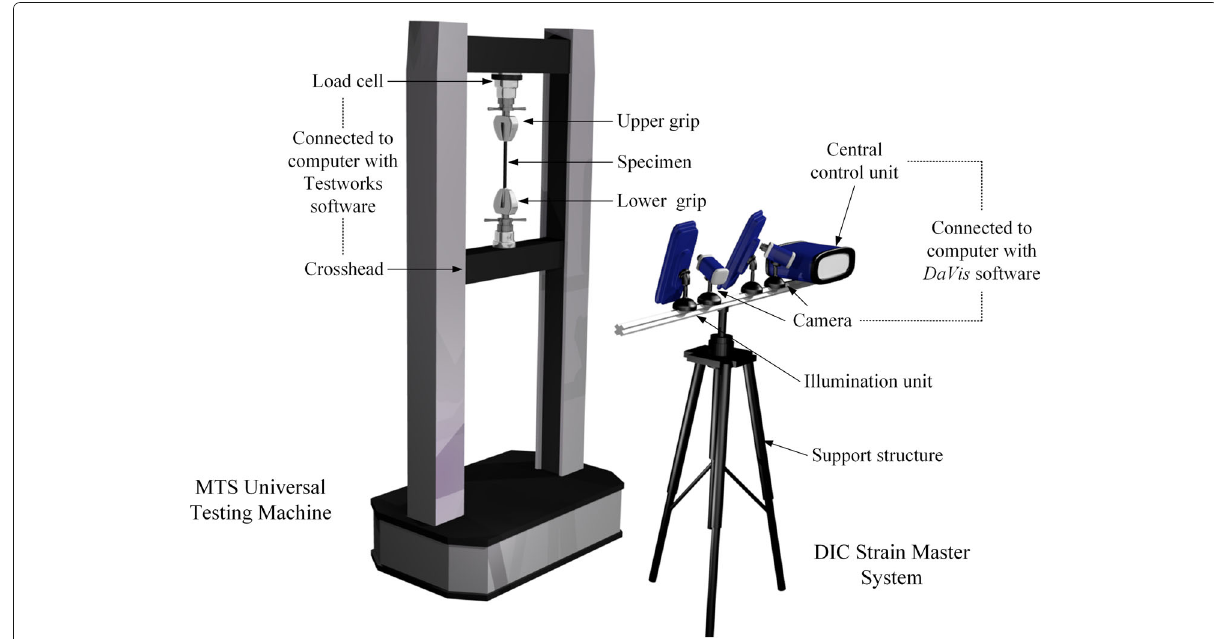
Fig. 3 Setup for tensile testing of rubber specimens consisting of the MTS Universal Testing Machine and the DIC Strain Master System